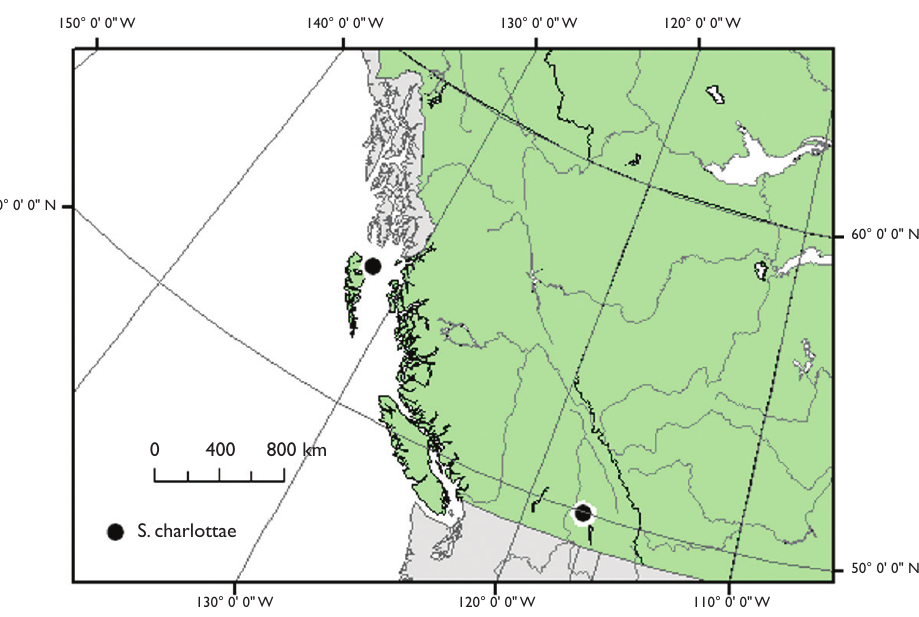
Map 1. Collection localities in Canada of S. charlottae